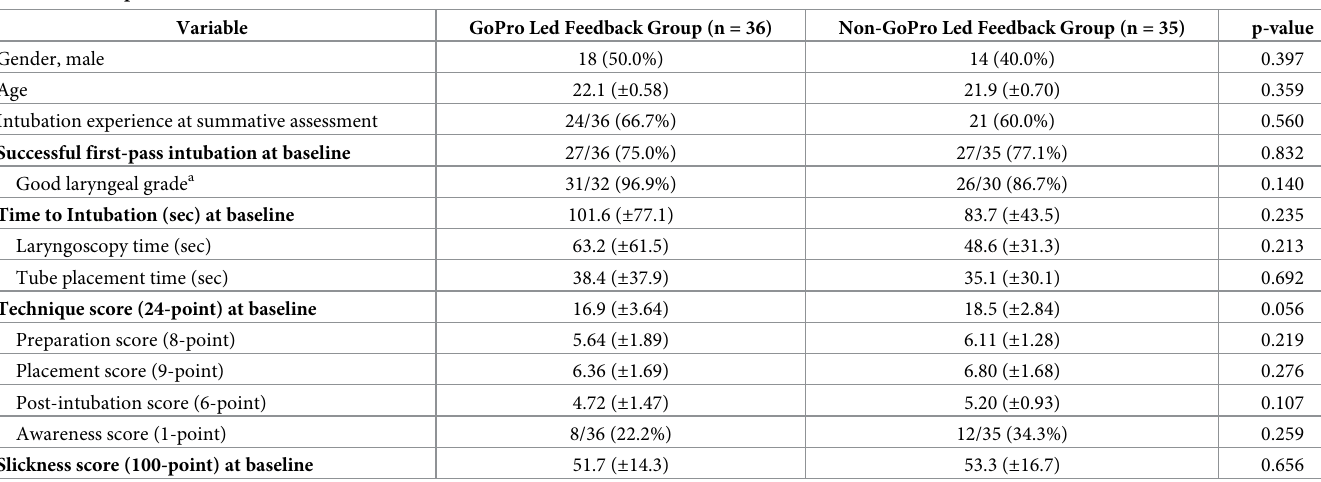
Fig 1. CONSORT diagram of patient enrollment, formative assessment, summative assessment, and data analysis. https://doi.org/10.1371/journal.pone.0243217.g001 Table 1. Descriptives and baseline